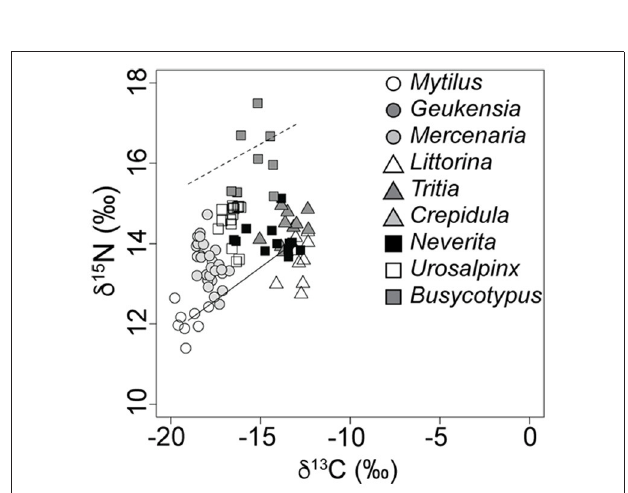
FIGURE 4 | The Milford, CT, food web as sampled during the summer of 2007. Dashed line indicates expected N. duplicata nitrogen signatures if they are predators (average baseline proxy value + 3.4 ‰ ). Inclination of the dashed line follows the inclination of the isotopic baseline as measured by proxy taxa (solid line).